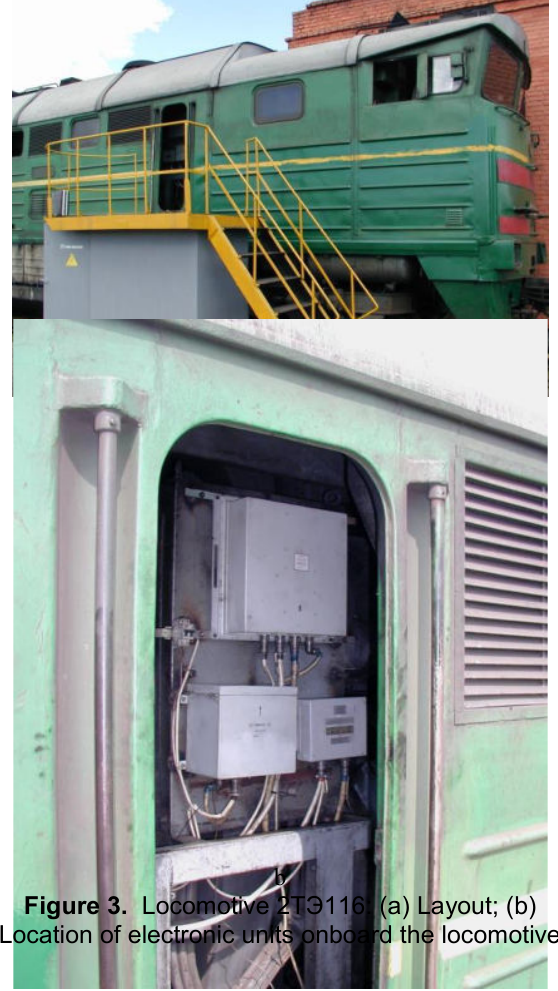
Figure 3. Locomotive 2ТЭ116 : ( а ) Layout; (b) Location of electronic units onboard the locomotive